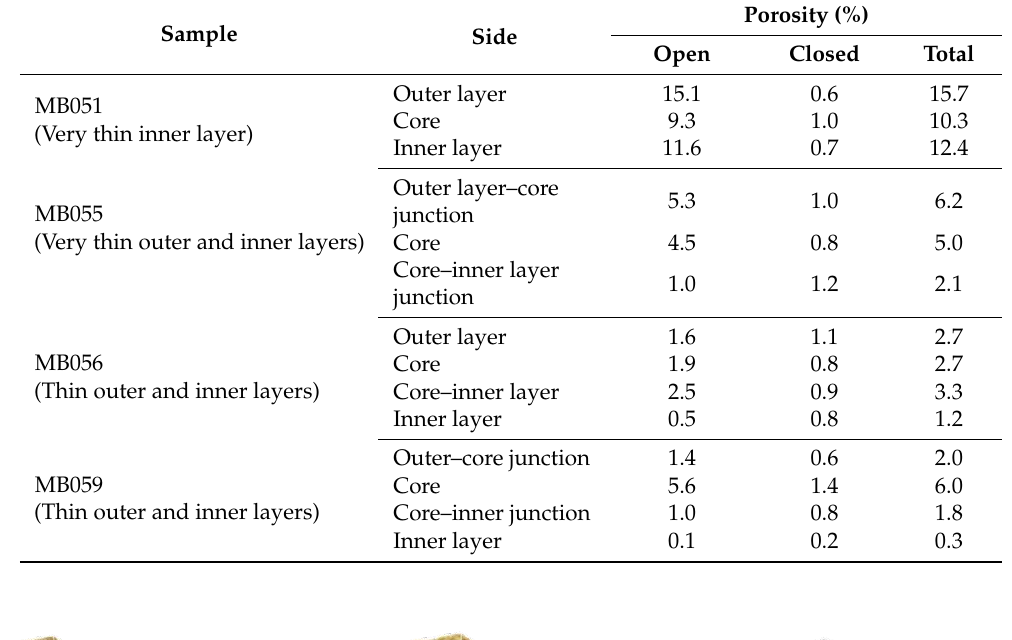
Table 4. Porosities of 4 selected samples analyzed using SR XTM.